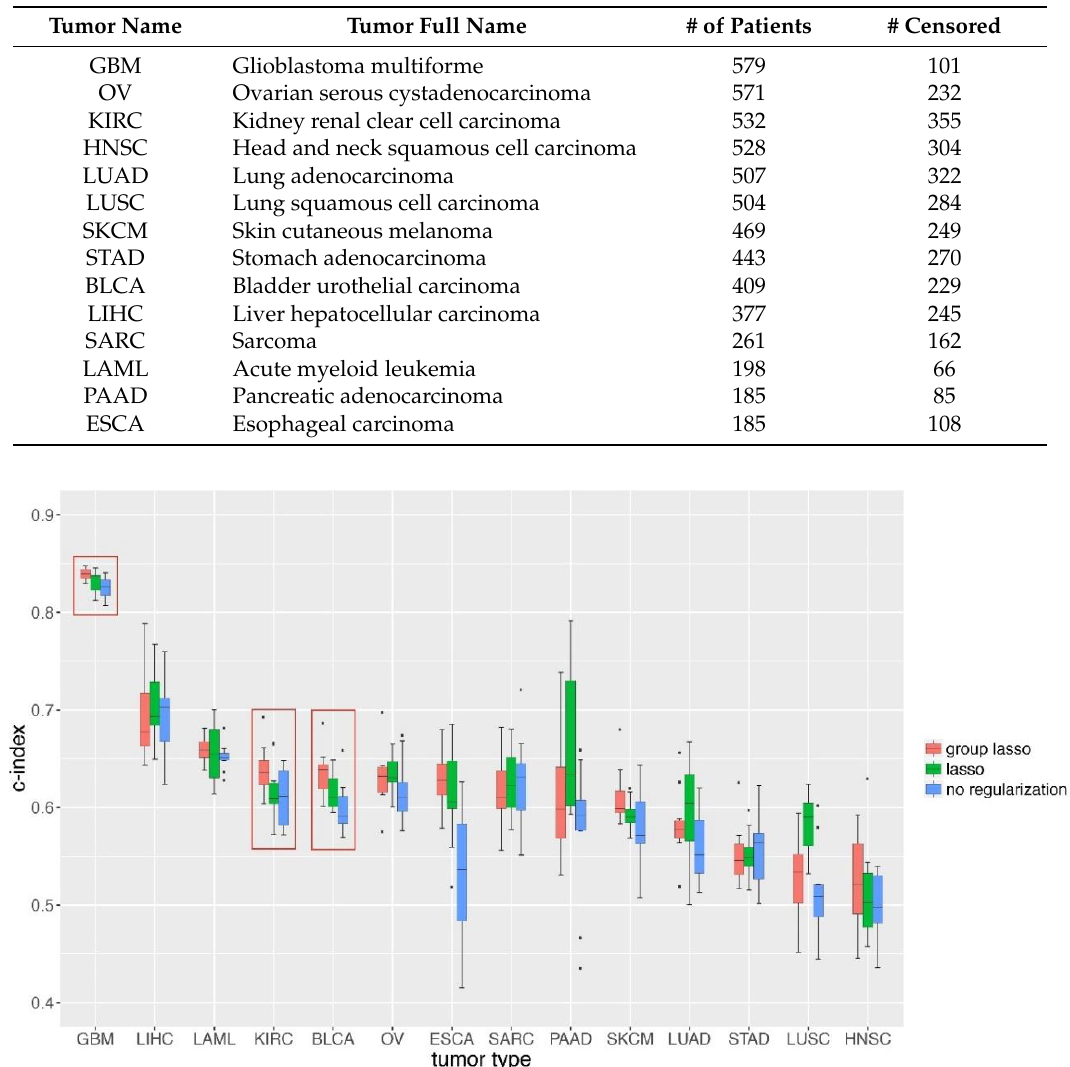
Figure 5. Group lasso performed significantly better regarding survival prediction for GBM, KIRC, and BLCA than the lasso method. GDP survival analysis was done on 14 tumor types from TCGA (Table 1). The group lasso method was compared to lasso and no regularization scenarios. For each tumor type datasets, 20% of the data was kept as testing datasets, and 80% of them was used for training and evaluation. Among this 80%, 75% was used for training and 25% was used for cross- evaluation.